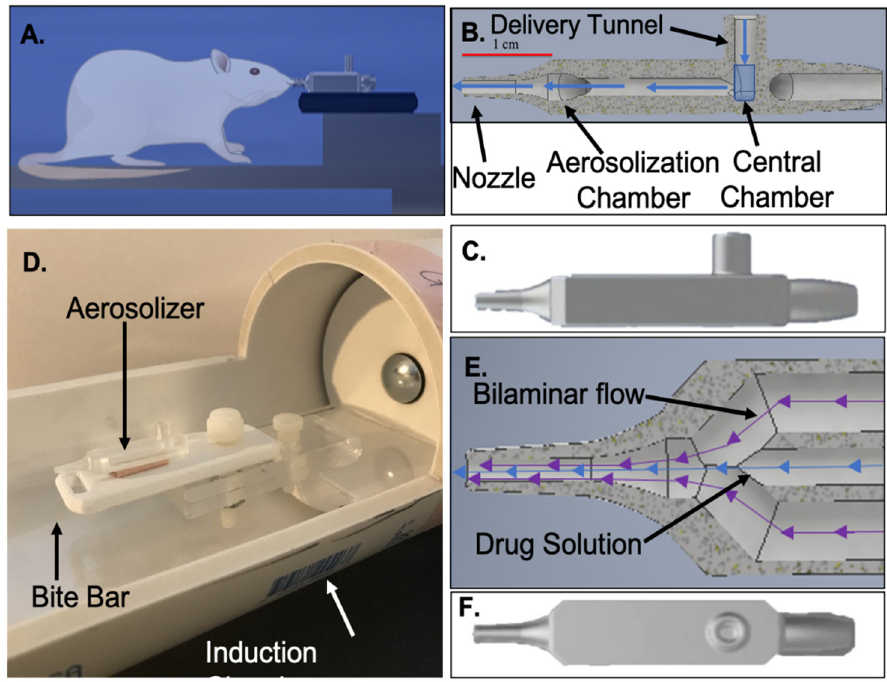
Figure 3. Intranasal aerosolizer set up. ( A ) Schematic of the aerosolizer relative to a cartoon of a rat. ( B ) Sagittal view of the internal component of the aerosolizer with a central chamber, delivery tunnel, aerosolization chamber, and nozzle in a manner very similar to Piazza et al., [16]. ( C ) Sagittal outer view of the aerosolizer. ( D ) Aerosolizer attached to the induction chamber tooth bar apparatus. ( E ) Top-down view of the internal component of the aerosolizer at the nozzle. The direction of the outer bilaminar flow of air (purple arrows) is shown, which then mixes with the central drug solution (blue arrows) to aerosolize the solution. ( F ) Top-down view of the outer aerosolizer.